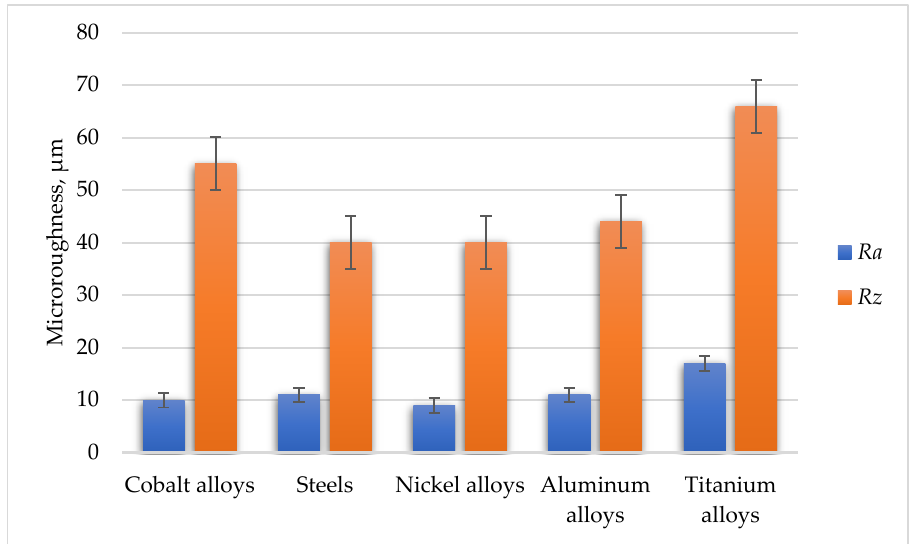
Figure 1. Arithmetic mean deviation ( R a ) and ten-point height ( R z ) of the product surfaces produced by laser powder bed fusion (selective laser melting) for various types of metals and alloys.